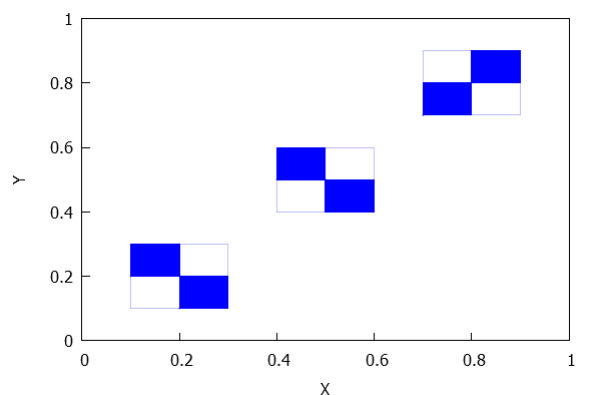
Figure 9. A and B mixing. Distribution D4. | L | = 6. A contains 3 disjoint intervals and f 1 ( A ) ∩ Int ( B ) = ∅ but f 1 ( A ) ∩ B (cid:54) = ∅ ; B has 3 disjoint intervals. | L 1 | = | L 2 | = 3 and rectangles of both sets have a common vertex.